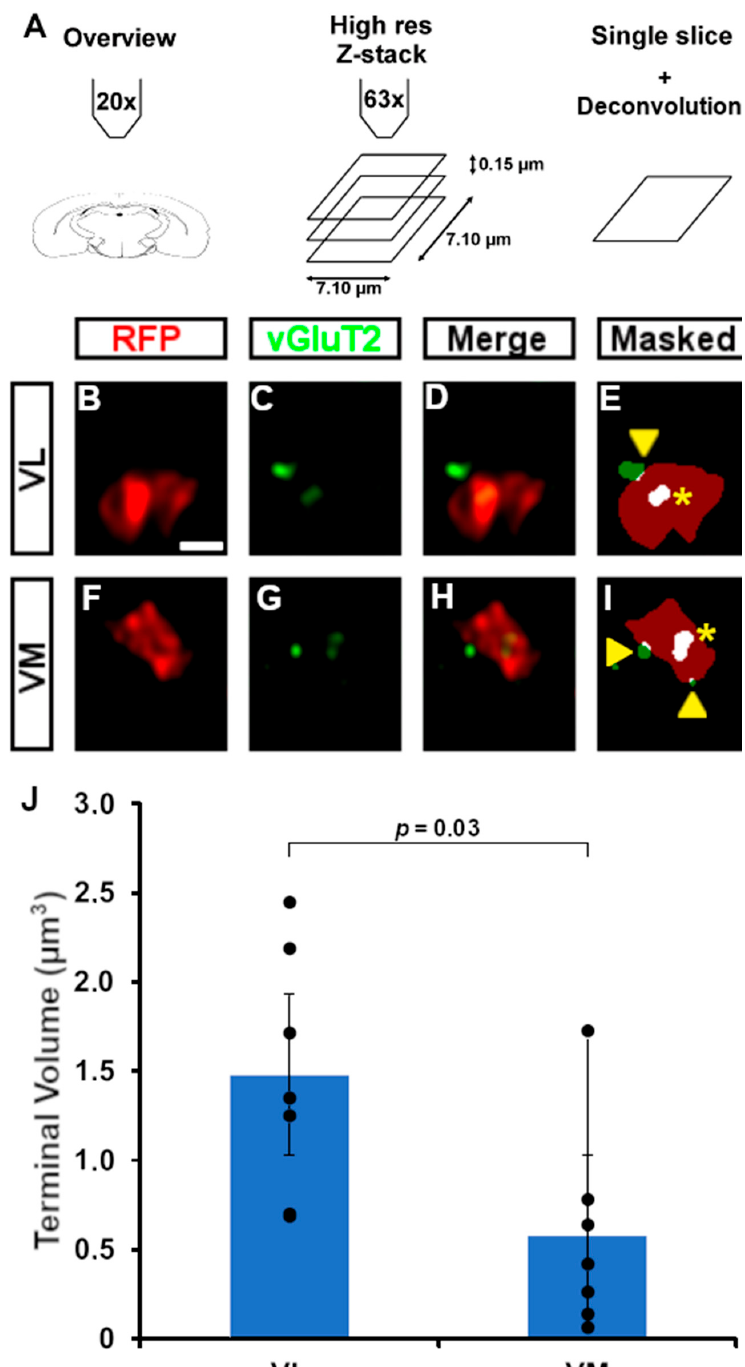
Figure 11. Putative boutons and colocalization with vGluT2. ( A ) Schematic overview of the workflow. After taking an overview image at 20 × , we acquired z-stacks at 63 × . Single optical slices were deconvolved and a user determined threshold was used after which we determined the overlap between fluorophores. RFP + boutons were considered to colocalize with vGluT2 if the vGluT2-fluorescence overlapped completely in all dimensions. ( B – E ) Example of a deconvolved image of a putative bouton in VL, with RFP in red (B), vGluT2 in green (C), colocalization of RFP and vGluT2 (D), and the result after thresholding (E). Asterisks indicate complete overlap, arrowheads indicate partial overlap, the latter of which is not considered for further analysis. ( F – I ) as ( B – E ) for VM. ( J – M ) as ( B – E ) for Pf. (N) Terminal volumes (in µm 3 ) in VL and VM. Scale bars: ( B – M ) = 1 µm.